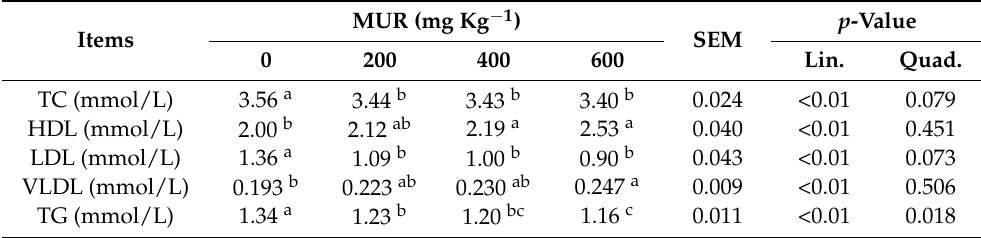
Table 7. Effect of MUR on serum lipid profile of broiler chickens.